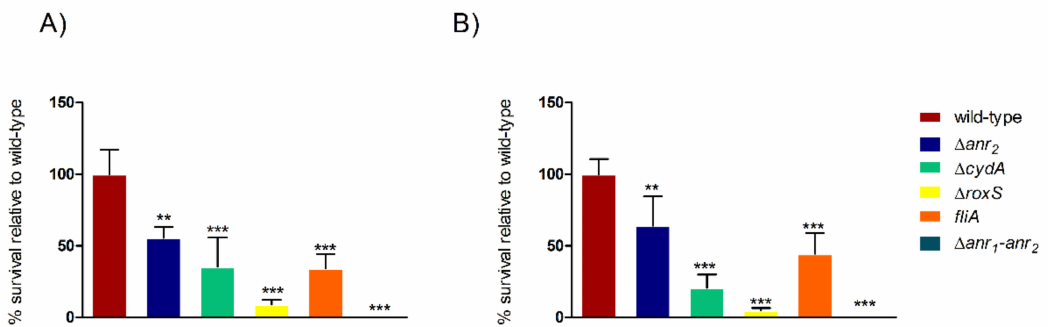
Figure 4. Anoxic survival of B. cenocepacia H111 wild-type and various mutants in ABC ( A ) and ABC with 10 mM NaNO 3 ( B ). Y-axis shows the normalized survival in % relative to the wild-type survival according to the start and end number of CFU. Three biological replicates ( n = 3) were performed for each survival experiment. The SD is shown by the error bars. A non-matching paired one-way ANOVA (Dunnett) was performed with confidence interval of 99%. *** = p -value < 0.001. ** = p -value <